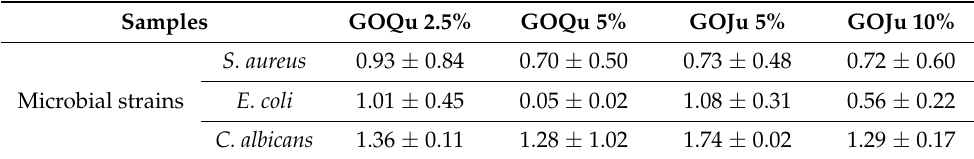
Table 1. Therapeutic index of the novel drug delivery system. Samples